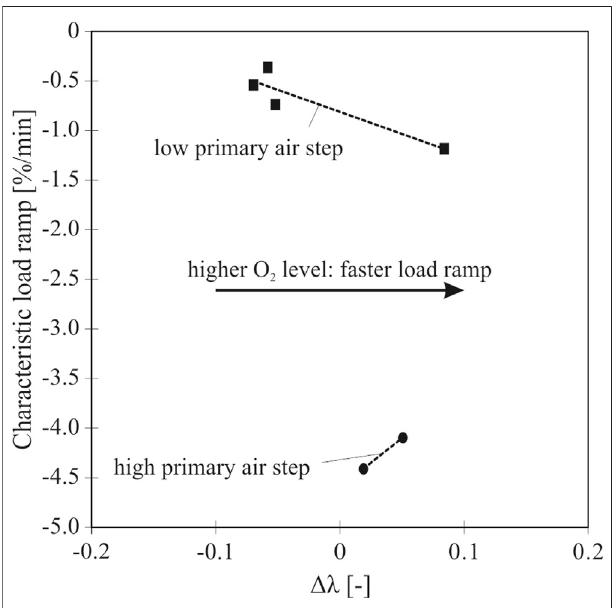
FIGURE 11 | In fl uence of the excess air factor on the characteristic load ramp during load